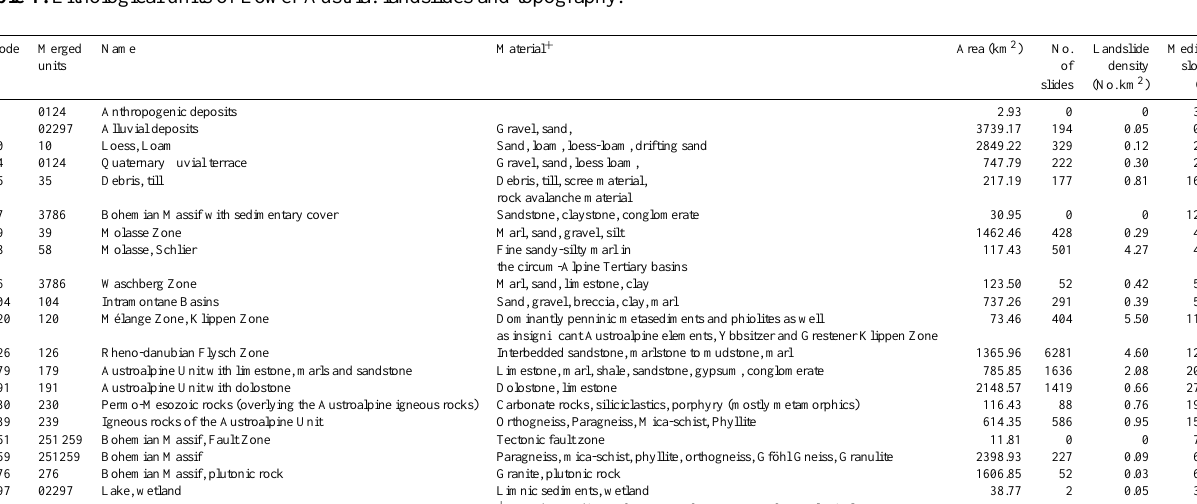
Table 1. Lithological units of Lower Austria: landslides and